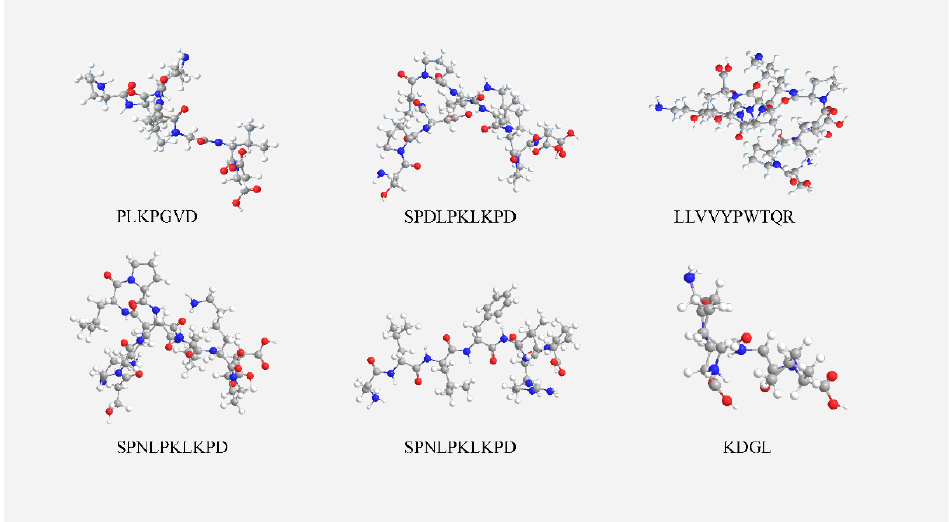
Figure 4. Three-dimensional structure of the peptide. The diagram shows the 3D structure of the peptide. The red spheres are oxygen atoms, the blue spheres are nitrogen atoms, the gray spheres are carbon atoms, and the white spheres are hydrogen atoms.